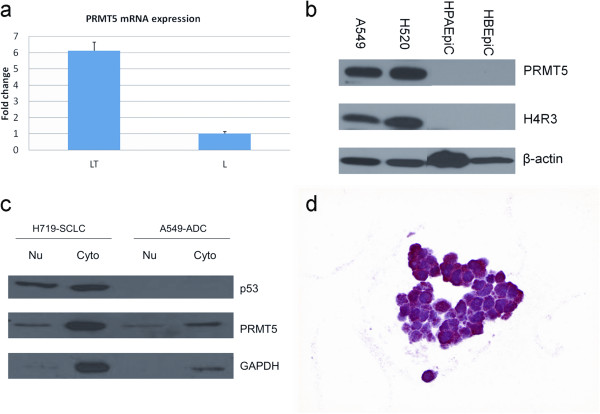
PRMT5 overexpression in lung cancer is evident at mRNA and protein levels. (a) There is a 6.13-fold increase in PRMT5 mRNA levels in lung tumors (LT), 8 cases, over matched nonneoplastic pulmonary parenchyma (L), as evident by TaqMan real time polymerase chain reaction (PCR). (b) PRMT5 and its symmetric methylation mark H4R3 are detected in lung carcinoma cell lines (NCI-A549, NCI-H520) but not in the nonneoplastic human pulmonary alveolar (HPAEpiC) and bronchial epithelial cell lines (HBEpiC); cellular localization experiments highlight nuclear and cytoplasmic fractions of PRMT5; Western immunoblot (b, c); immunohistochemistry (d), NCI-H69, original magnification ×600.